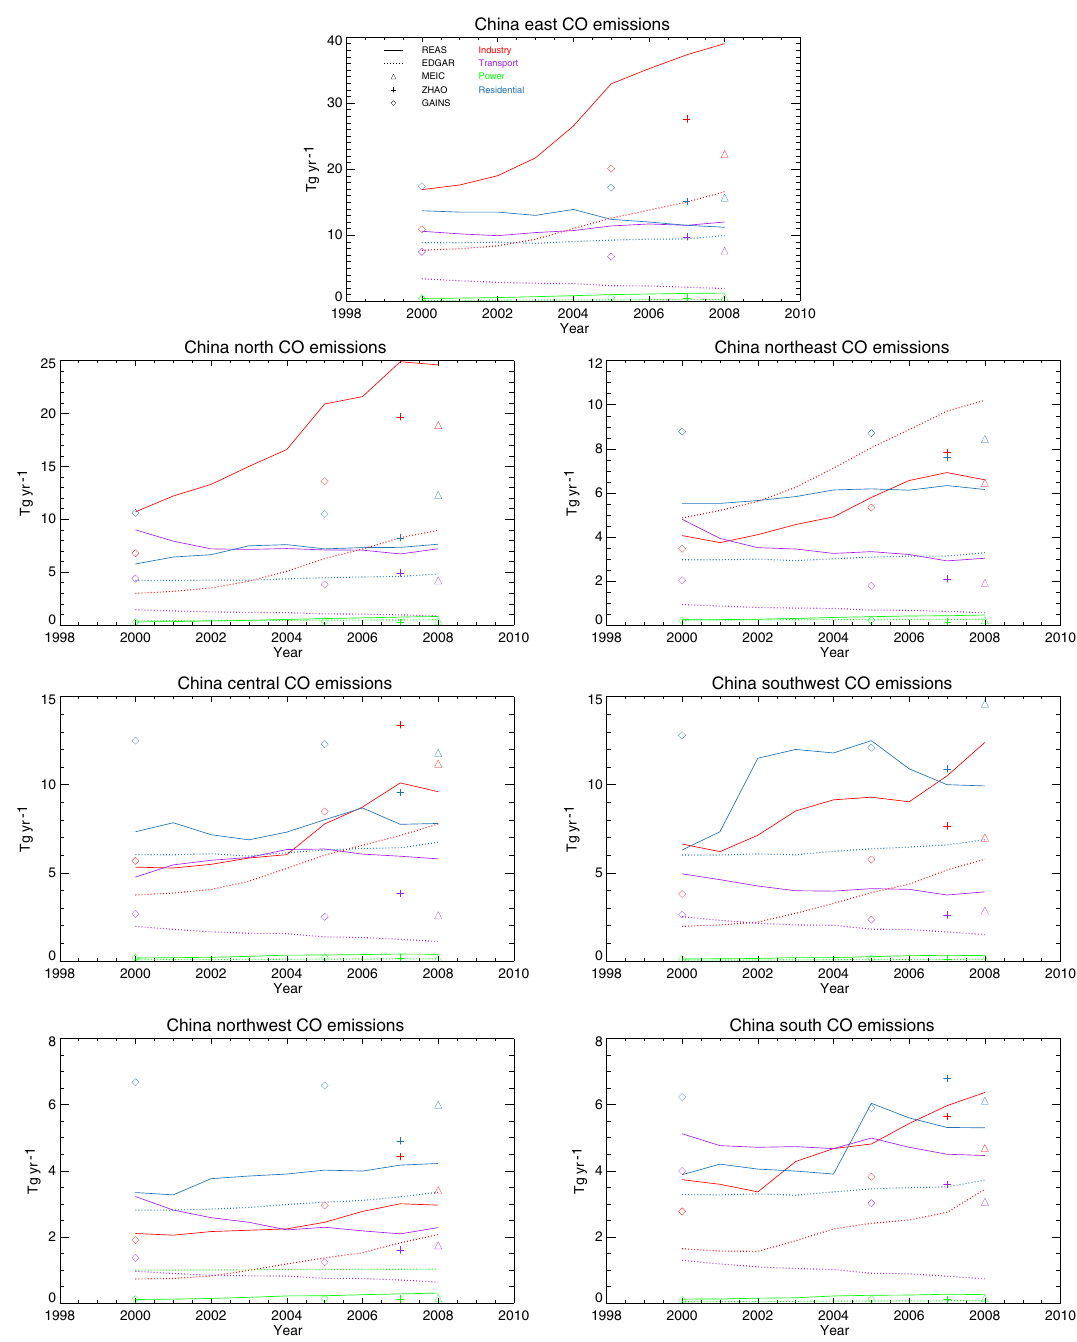
Figure 6. Regional total emissions for CO for four different source sectors (industry, transport, power, and residential) estimated by REAS, EDGAR, MEIC, ZHAO, and GAINS between 2000 and